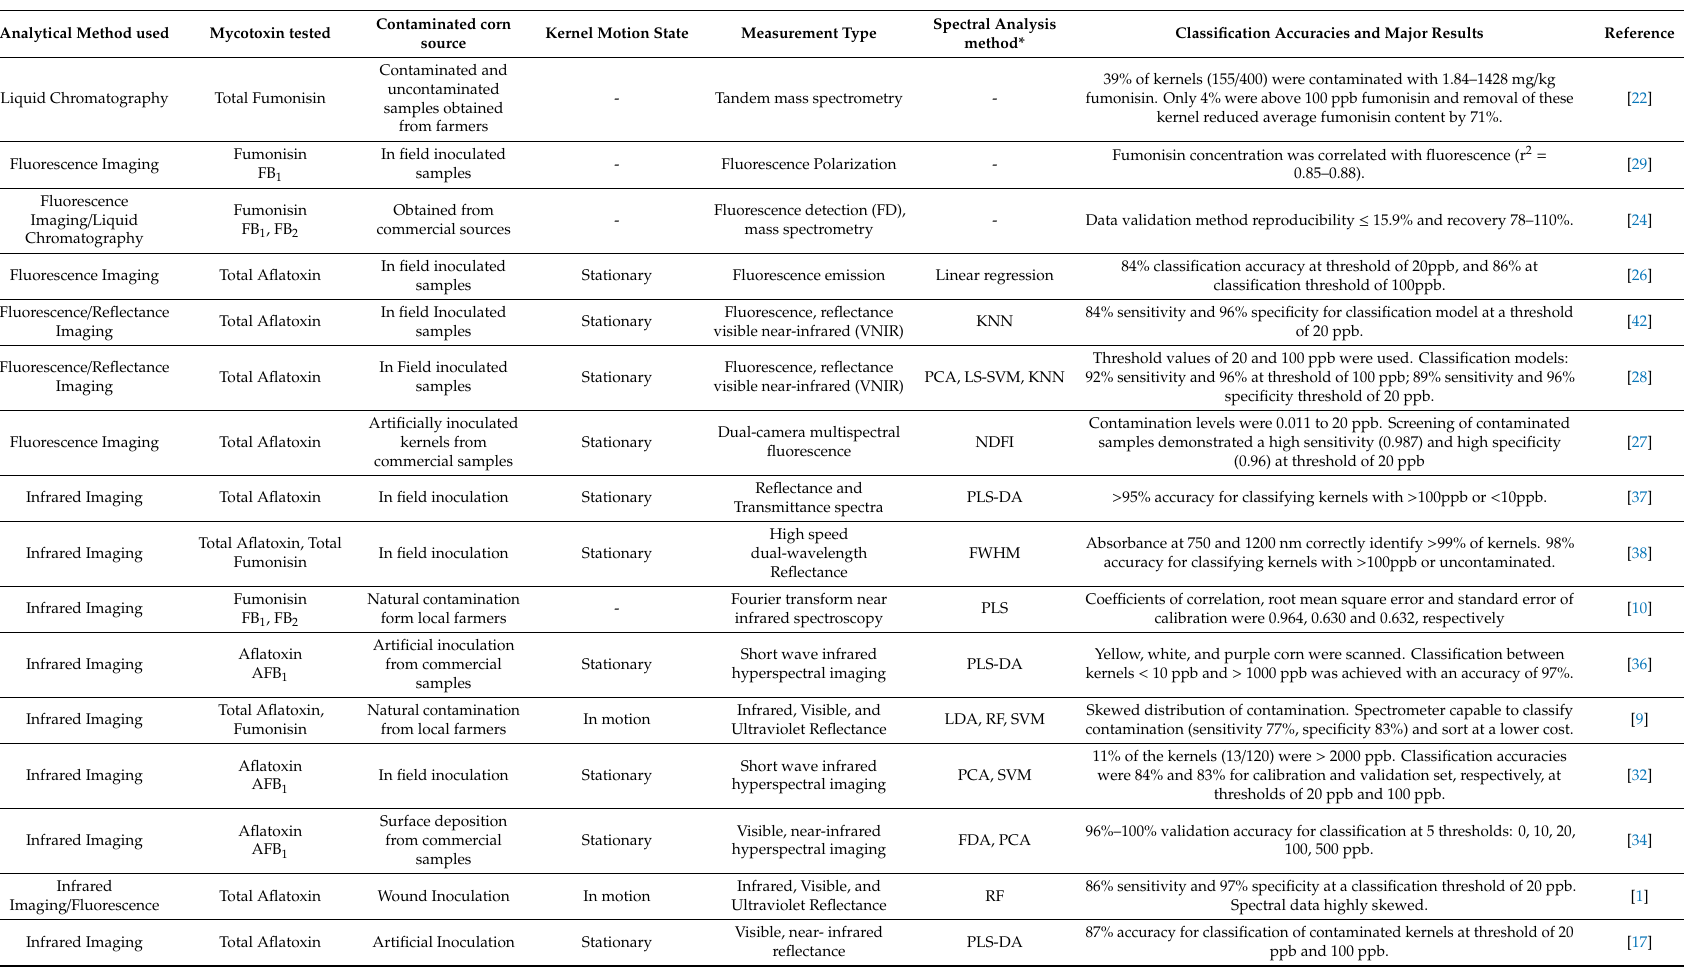
Table 1. Summary of research studies that report single corn kernel aflatoxin and fumonisin contamination detection using di ff erent analytical